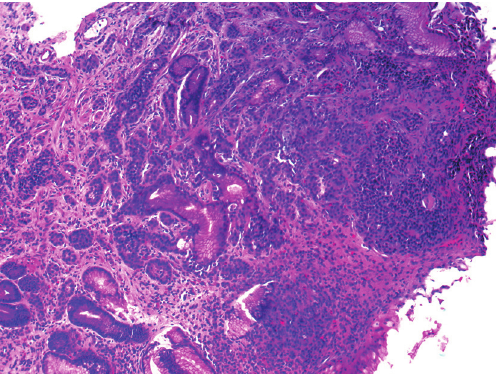
F 1: Histological morphology of gastric carcinoid consists of well-differentiated nests with granular cytoplasm and round to oval nuclei